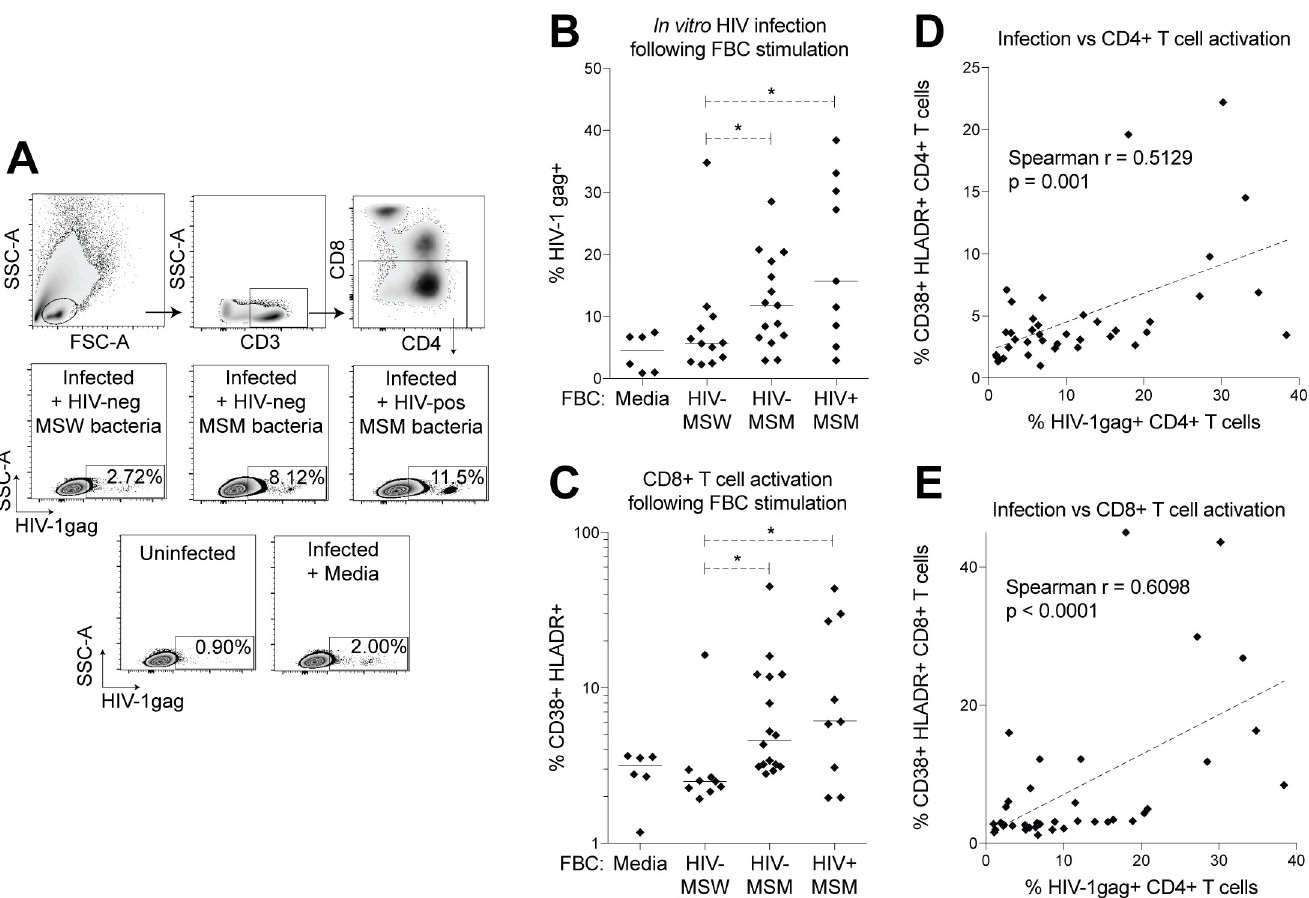
Fig 6. Fecal bacterial communities isolated from HIV-negative and HIV-positive MSM promote HIV infection of primary human lamina propria cells. Primary lamina propria cells (LPCs) were isolated from human jejunum tissue, stimulated with isolated fecal bacterial communities (FBCs) from HIV-negative MSW (n = 12), HIV-negative MSM (n = 15), and HIV-positive MSM (n = 9) donor feces, and infected with HIV bal . LPCs were stained for intracellular HIV-1gag expression and T cell activation markers at 5 days post-infection using flow cytometry. (A) Gating strategy for HIVgag+ T cells. (B–C) Comparison of levels of (B) HIV-1gag+ cells and (C) CD38+ HLADR+ CD8+ T cells following infection. Each data point represents the median value of one FBC tested across 3 different individuals’ LPCs. Lines represent medians within groups. Statistical analyses were performed using t-tests to compare groups if data from both groups had normal distributions and Mann- Whitney tests to compare groups if data from at least one group had a non-parametric distribution. � = p < 0.05. (D–E) Spearman correlations between frequencies of HIV-1gag+ cells and frequencies of (D) CD38+ HLADR+ CD4+ T cells, and (E) CD38+ HLADR+ CD8+ T cells. Dotted lines represent linear regression analyses.